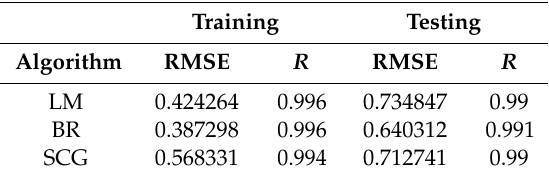
Table 3. Performance of different training algorithms in NARX model.